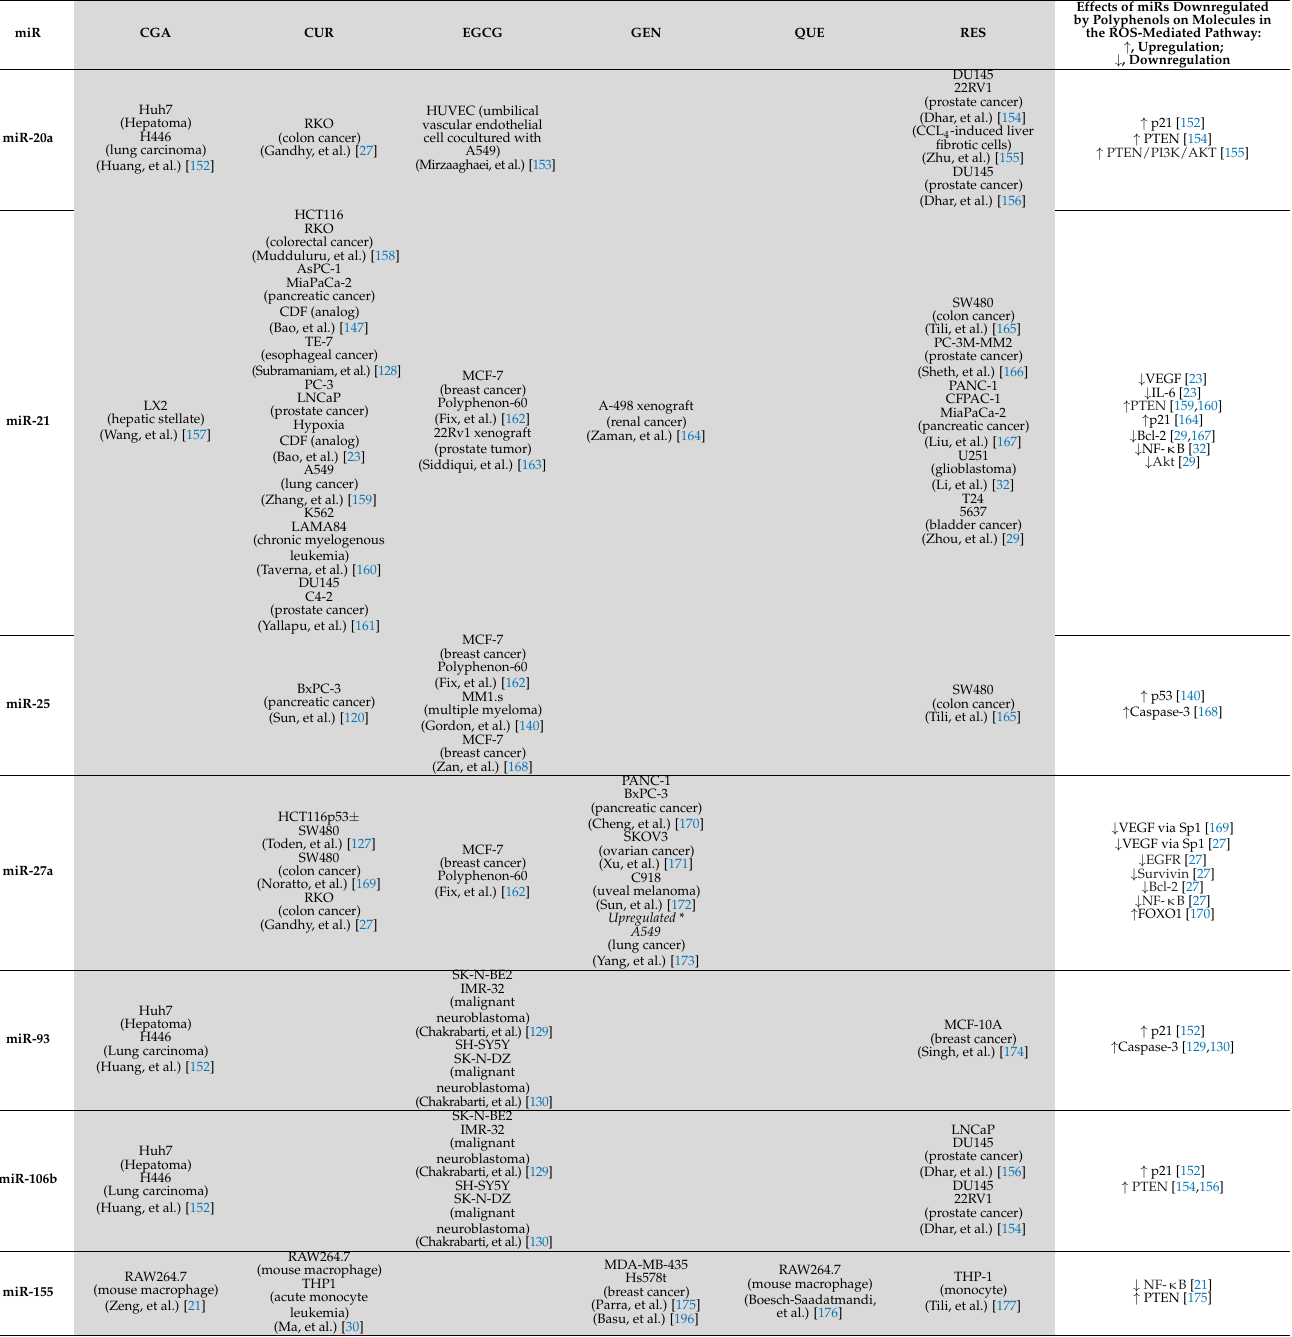
Table 5. miRs downregulated by polyphenols, cell types examined, and effects of miR